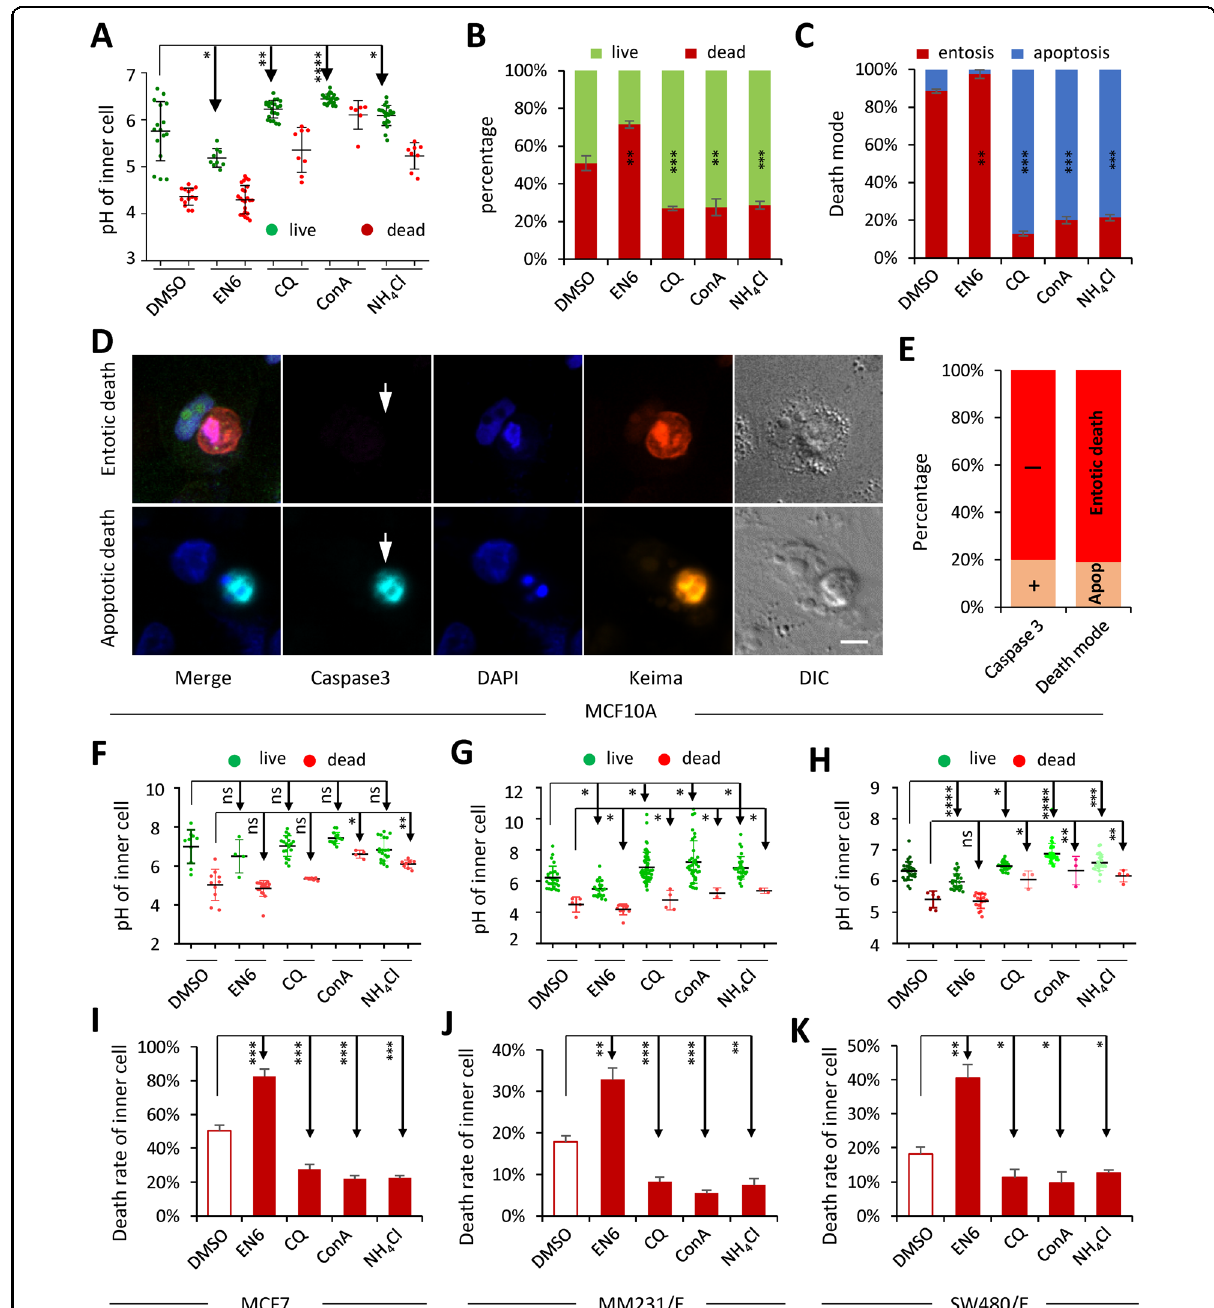
Fig. 5 The fates of inner cells were controlled by vacuolar pH. The pH of vacuoles containing live or dead inner cells ( A ), and inner cell fates ( B ), and the ways inner cells died (entotic or apoptotic) ( C ), for MCF10A cells upon treatments with EN6 (10 μ M), CQ (20 μ M), ConA (200 nM), and NH 4 Cl (100 μ M). n (left to right) = 30, 33, 30, 31, 30 for A ; 96, 98, 89, 94, 104 for B ; 150, 129, 76, 65, 60 for C . ** p < 0.01; *** p < 0.001. D Representative images of CICs, with inner cells undergoing entotic death (up) or apoptotic death (low), that were stained with antibody for cleaved-caspase 3 (cyan). Keima for merged channels of 440 and 550 nm. White arrows indicate inner cells. Scale bar, 10 μ m. E Quanti fi cation of inner cells that were positive in cleaved-caspase 3, or died either entotically or apoptotically. n (left to right) = 64, 57, respectively. The pH of vacuoles containing live or dead inner cells ( F – H ), and inner cell fates ( I – K ), for cells (MCF7, MM231/E, and SW480/E) upon treatments with EN6 (10 μ M), CQ (20 μ M), ConA (200 nM), and NH 4 Cl (100 μ M), respectively. n (left to right) = 26, 23, 26, 20, 28 for F ; 31, 32, 57, 38, 33 for G ; 36, 43, 32, 37, 32 for H ; 89, 78, 96, 80, 85 for I ; 117, 118, 159, 160, 108 for J ; 120, 108, 104, 134, 141 for K . * p < 0.05; ** p < 0.01; *** p < 0.001; **** p <